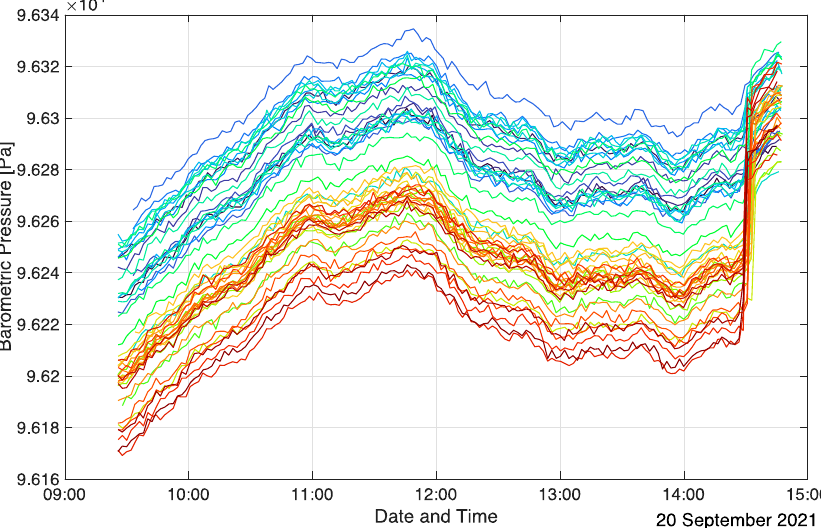
Figure 4. Uncompensated BMP390 values (prior to calibration) in an inclined auditorium.